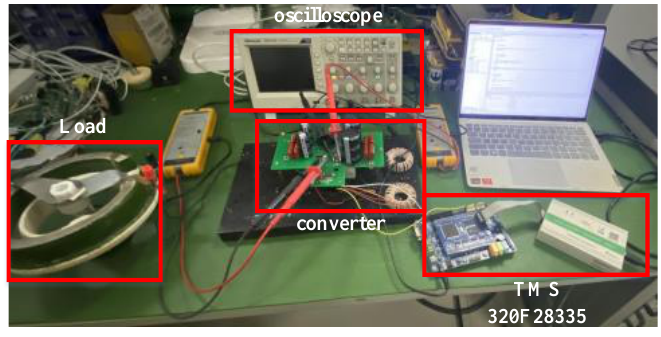
Figure 14. Experiment platform.